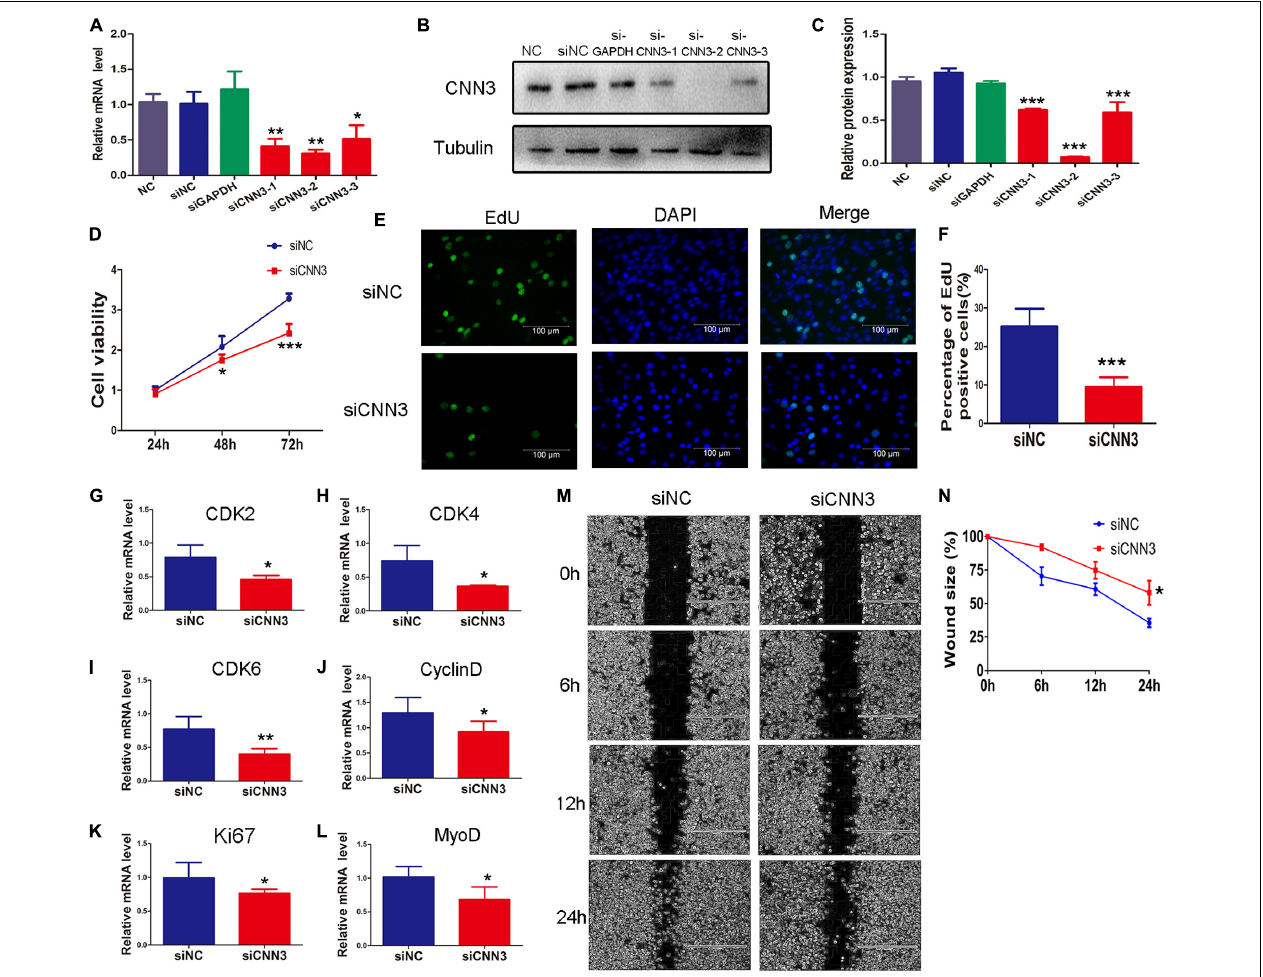
FIGURE 2 | The effects of CNN3 knockdown on proliferating myoblasts. (A) The relative mRNA expression of CNN3 after RNAi-mediated knockdown. (B,C) Western blot analysis of CNN3 and tubulin after CNN3 knockdown. (D) Cell viability assessed using the CCK8 assay. (E) Cell proliferation quantified by EdU labeling. The green color indicates EdU labeling, and the blue color indicates DAPI nuclear staining. (F) The percentage of EdU-positive cells among the total number of cells detected by DAPI nuclear staining. (G–L) Downregulated expression of (G) CDK2, (H) CDK4, (I) CDK6, (J) cyclin D, (K) Ki67, and (L) MyoD in the CNN3 knockdown group. (M) Phase contrast microscopy images of migrating C2C12 cells at 0, 6, 12, and 24 h after scratching. (N) Quantitative analysis of cells the percentage of migrating into the scratch area at 0, 6, 12, and 24 h after scratching. * P < 0.05, ** P < 0.01, *** P < 0.001 compared with the NC siRNA